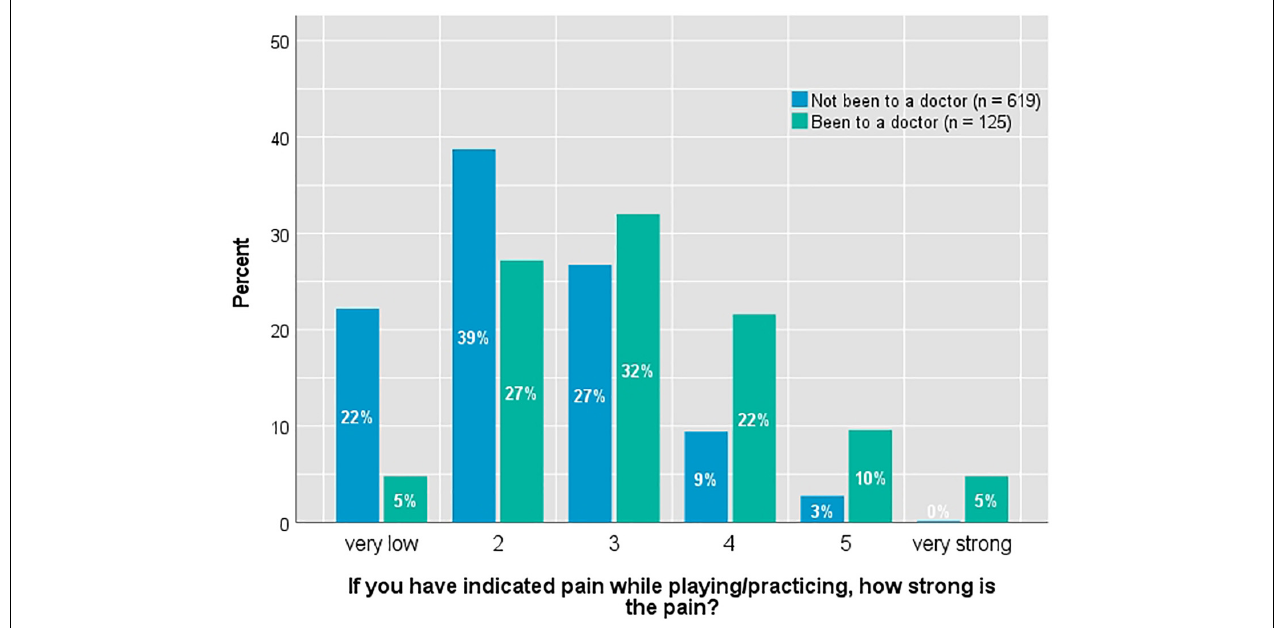
FIGURE 1 | Distribution of pain intensity in differentiation according to the visit of a physician.